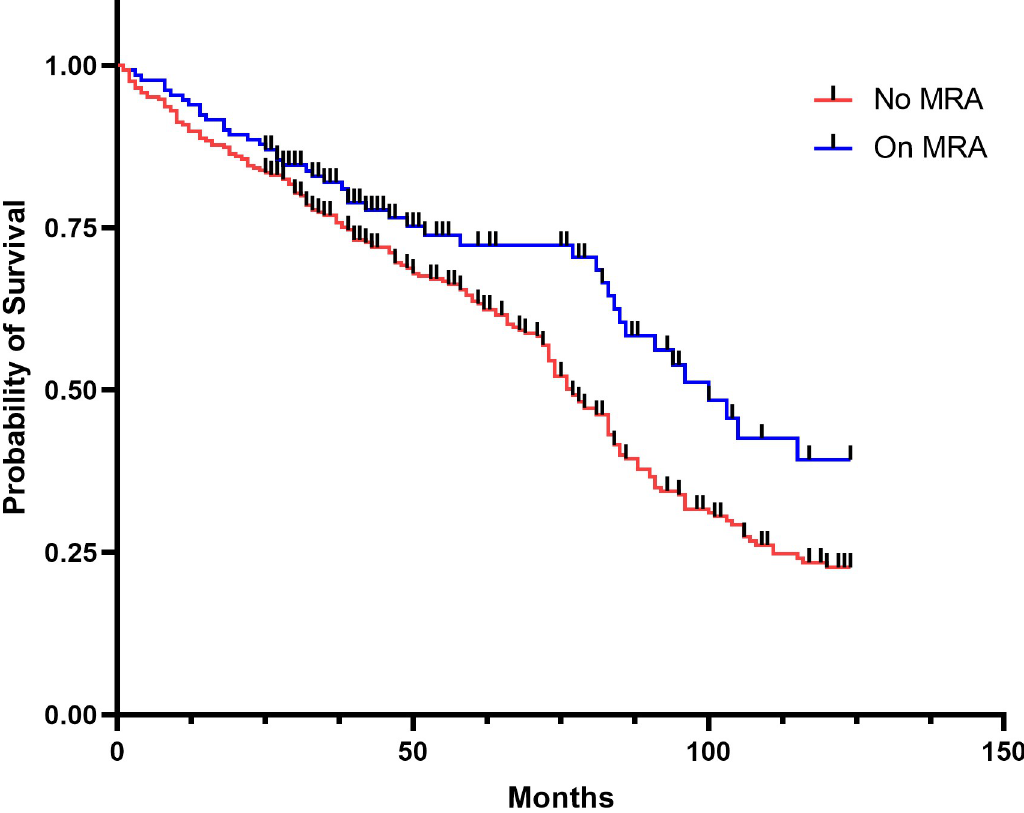
Fig 3. Kaplan-Meier survival plot for On MRA versus No MRA. Log rank p < 0.001. https://doi.org/10.1371/journal.pone.0258949.g003 in eGFR or worsening renal function. Moreover, MRA was not associated with adjusted all- cause mortality in HFrEF patients with moderately reduced index eGFR. A third of all patients developed WRF, regardless of treatment with MRA. Furthermore, in patients developing WRF, MRA was not associated with adjusted all-cause mortality. With an initial eGFR < 60 ml/min/1.73 m 2 , eGFR declined by a similar rate regardless of MRA use. Although eGFR declined by 20% (WRF) in about a third of all patients, use of MRA did not increase the risk of WRF. The mean decline in eGFR did not decrease below eGFR 30 ml/min/1.73 m 2 . If the patients that discontinued MRA would be added to the On MRA group, the percentage of patients experience WRF would be slightly higher, 34% instead of Table 3. Adjusted risk of all cause-mortality in HFrEF patients with moderately impaired renal function.